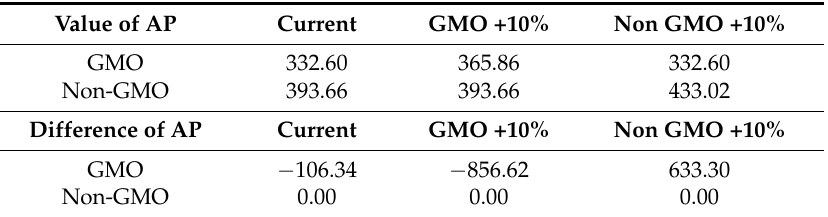
Table 11. Resume of differences in the adjusted profit for GMO and non-GMO